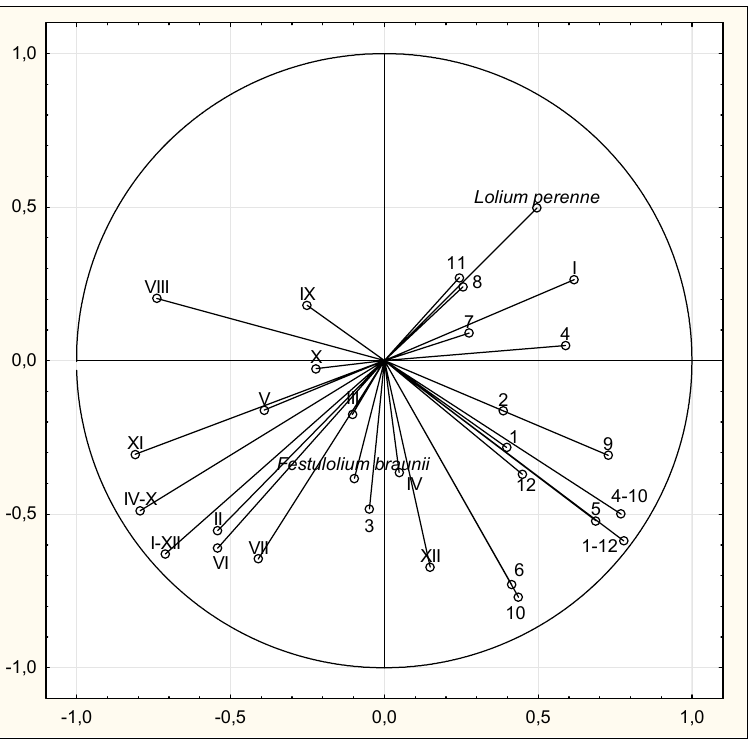
Figure 2. The principal component analysis (PCA) for Lolium perenne , Festulolium braunii abundance and weather conditions. Festulolium braunii-abundance in the sward, Lolium perenne-abundance in the swards. I–XII-rainfall (mm) in individual months. 1–12-air temperature in individual months.